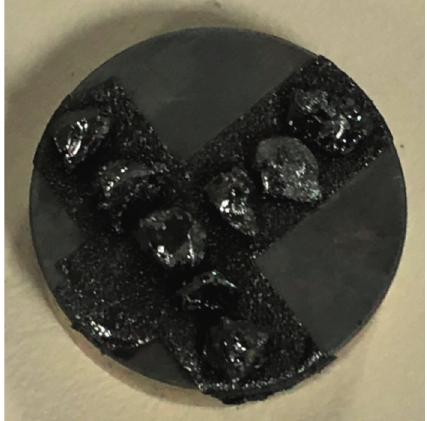
Figure 5: Specimens after the gold spraying